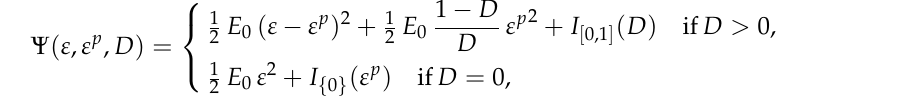
Table 1. Numerical errors (